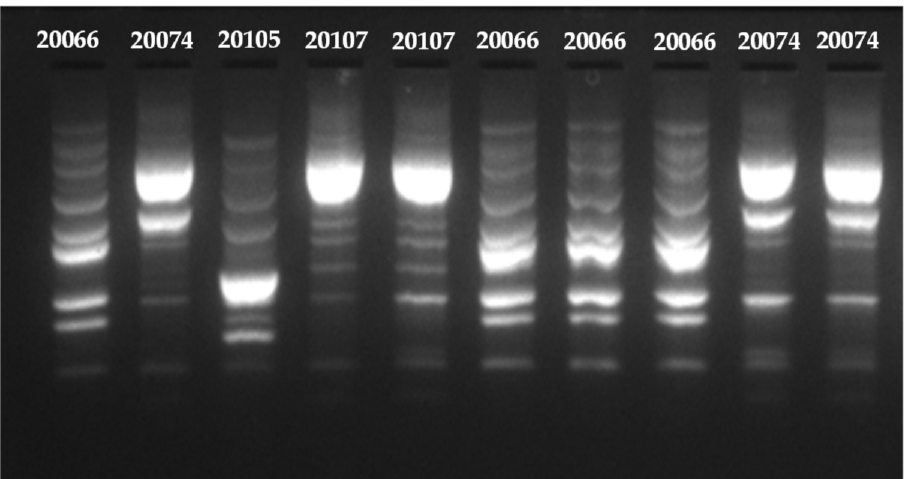
Figure 5. Characteristic repetitive sequence-based polymerase chain reaction (rep-PCR) profiles of 10 L. monocytogenes isolates, where it can be observed that each strain (AAL20066, AAL20074, AAL20105, and AAL20107) presents a distinct amplicon pattern enabling this way its easy discrimination from the other